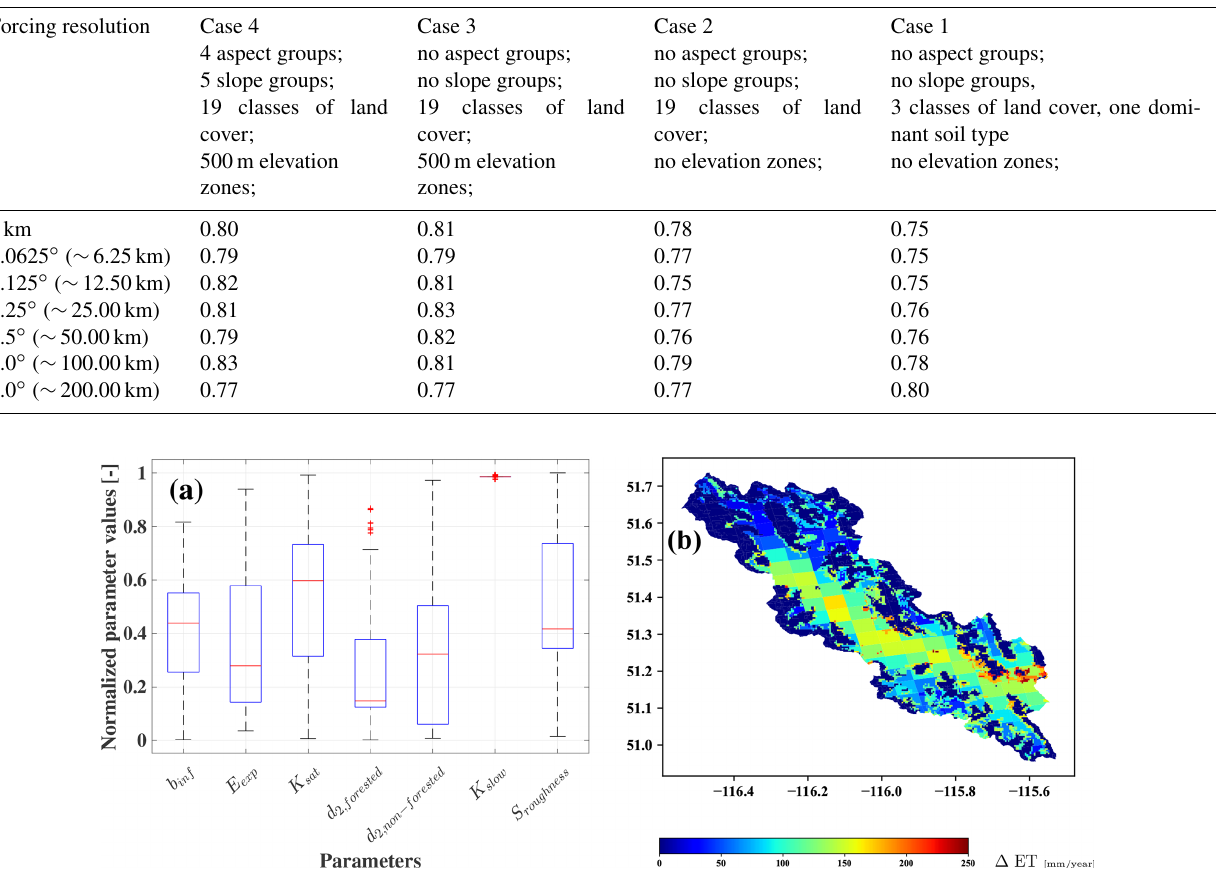
Figure 3. (a) The normalized values for the parameters of Case 2–4km that have E NS (Nash–Sutcliffe efficiency) values of higher than 0.7. (b) The difference of largest and smallest yearly simulated transpiration for parameter sets with E NS above